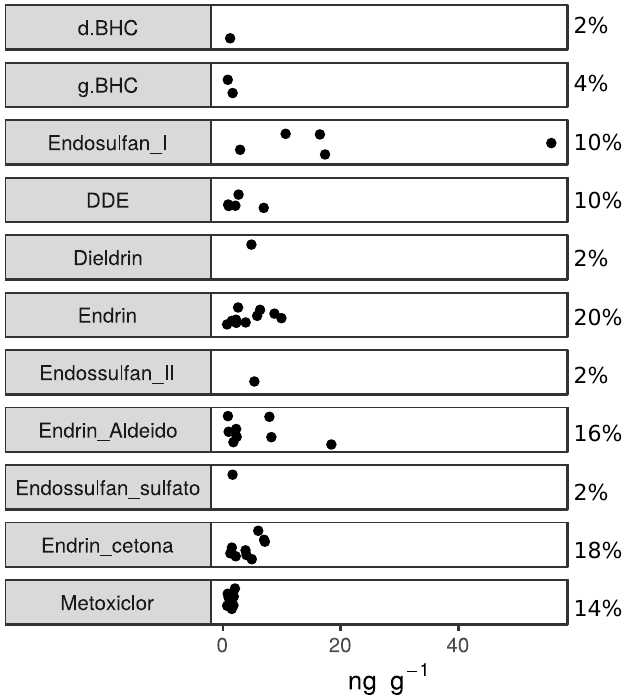
Figure A2. Jitter-plot graph of the detected OC concentrations (wet weight—ww) and percentages above the limit of quantification (%) in Sardinella brasiliensis muscle samples obtained during five different sampling campaigns carried out in Brazil (n =